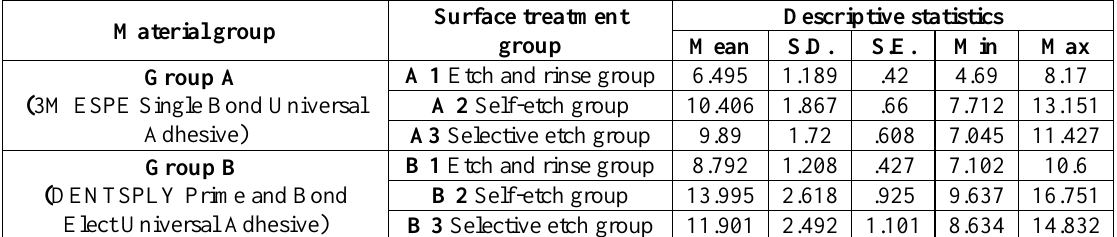
Table 2: Table showing mean, SD, SE, minimum and maximum of the data collected Material group